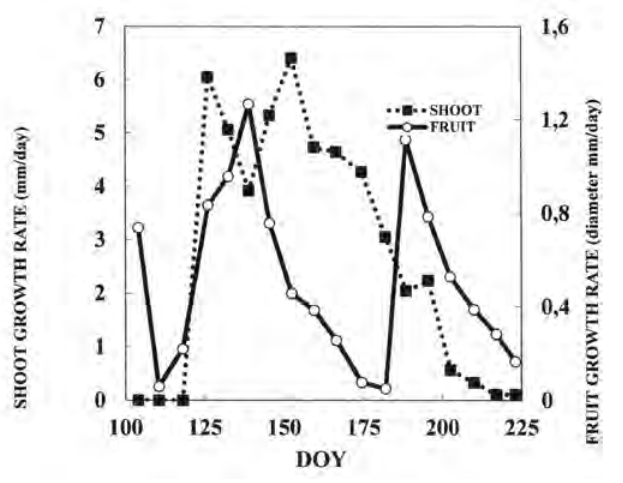
Fig. 16 - Seasonal growth rate of shoots and fruit of peach tree, cv. An - dross. When the former is high, the latter is low, and vice versa (Pitacco and Giulivo, 1992).